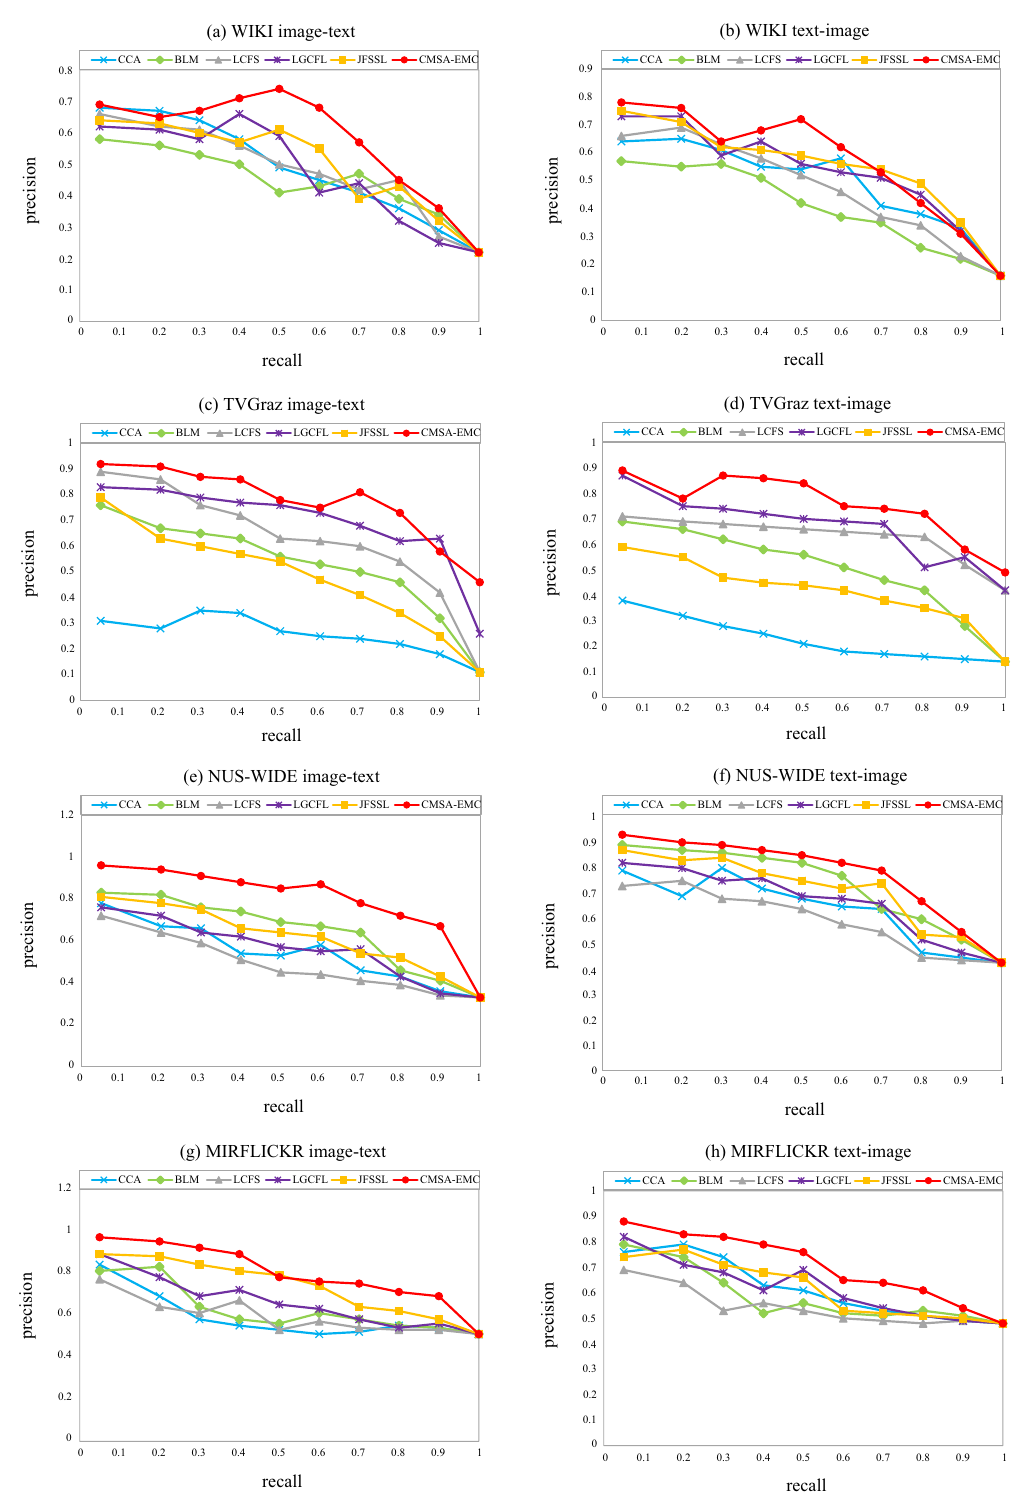
Figure 1. Precision–Recall (PR) curves of different methods. On the four datasets, We compared CSAEC with other five methods to prove the better results. The method completes the query task and improves the retrieval